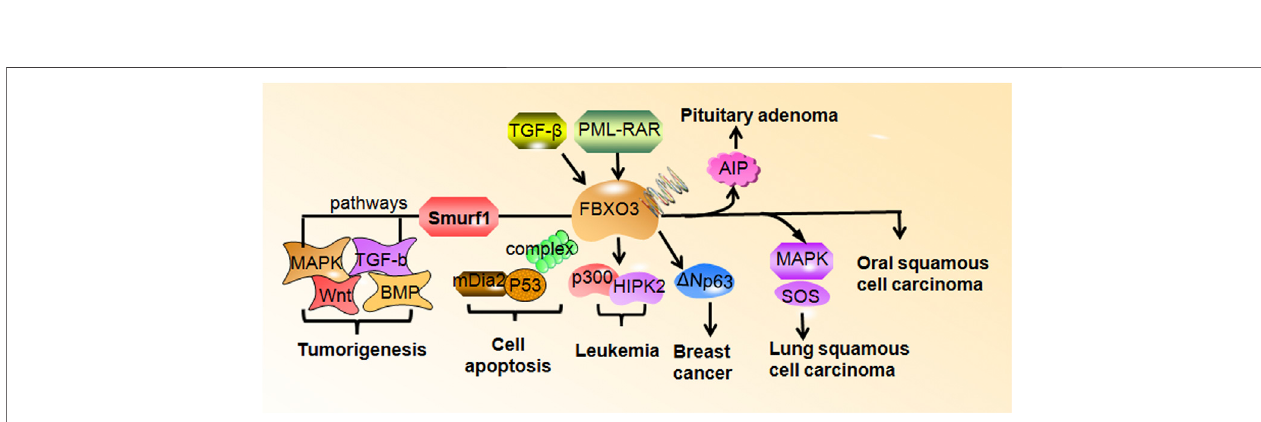
Frontiers in Cell and Developmental Biology |